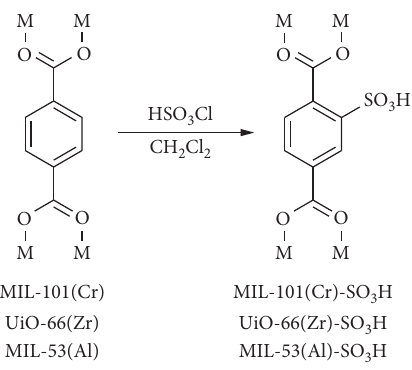
Figure 2: Preparation of MOF-SO3H for the conversion of fructose into HMF.